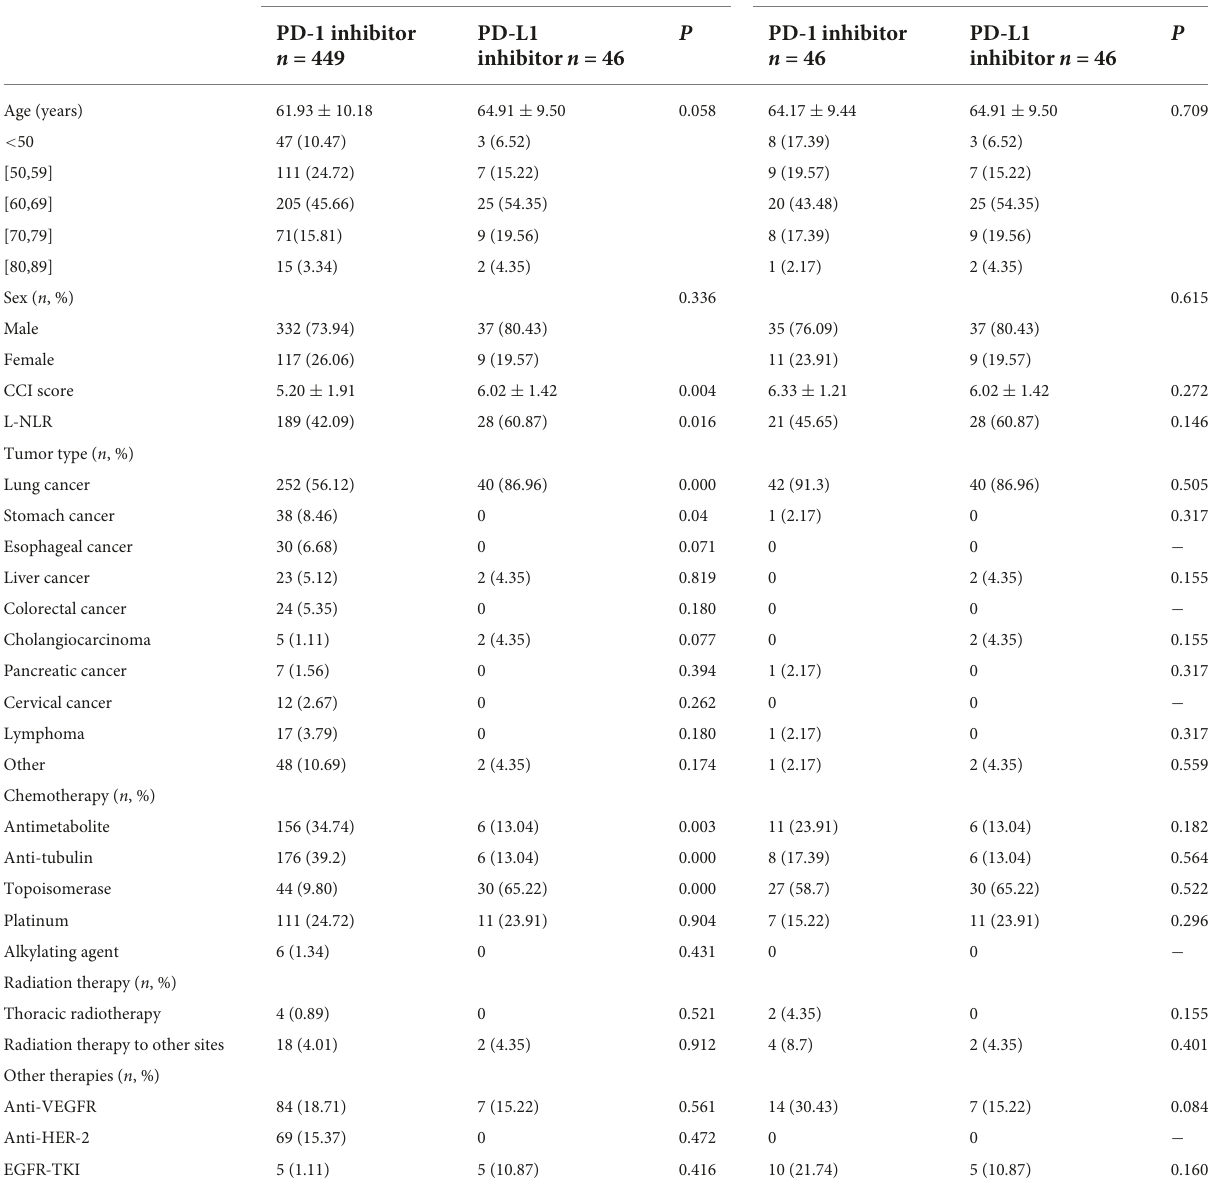
TABLE 3 Propensity matching of